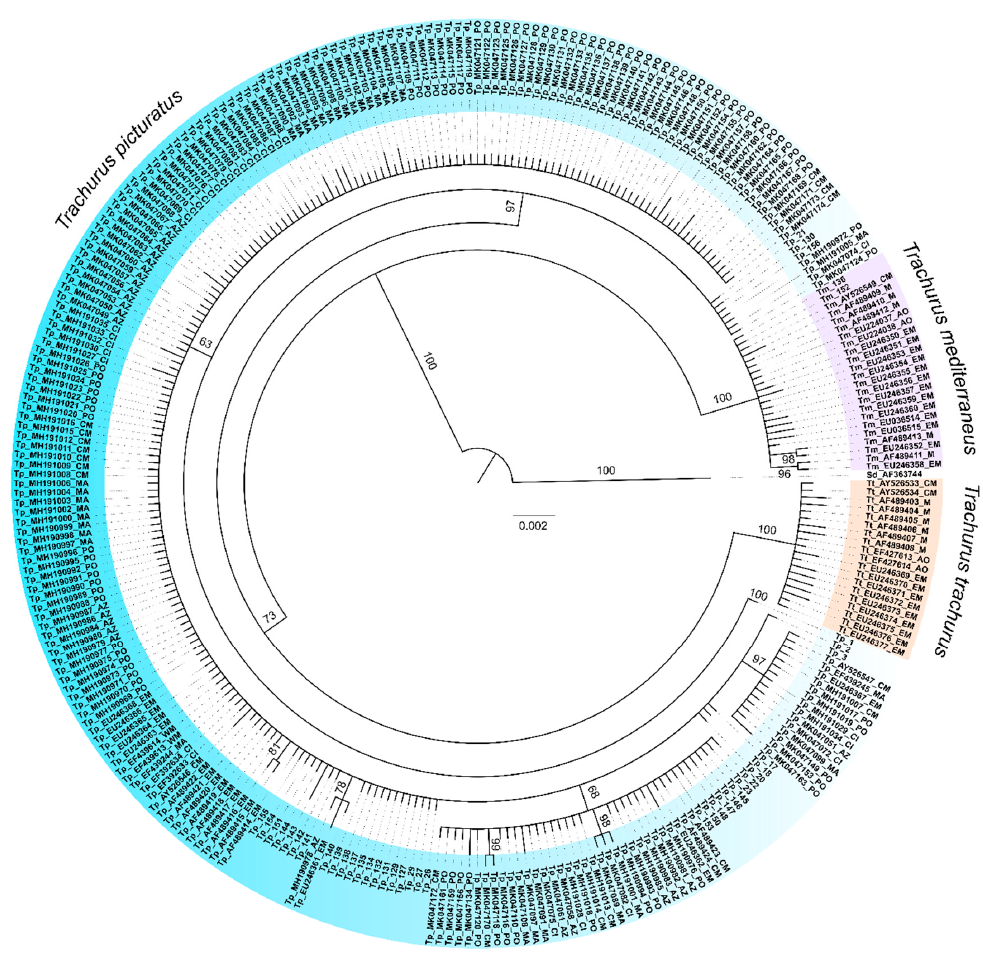
Figure 2. Rooted phylogenetic tree inferred by Bayesian analysis of mtDNA cytochrome b sequences, with posterior probability percentage shown for main nodes. Selene dorsalis (Carangidae) was used as an outgroup. Blue jack mackerel Trachurus picturatus was presented with 25 haplotypes. Sequence IDs of each Trachurus species were coloured differently for easier interpretation of the phylogenetic tree.